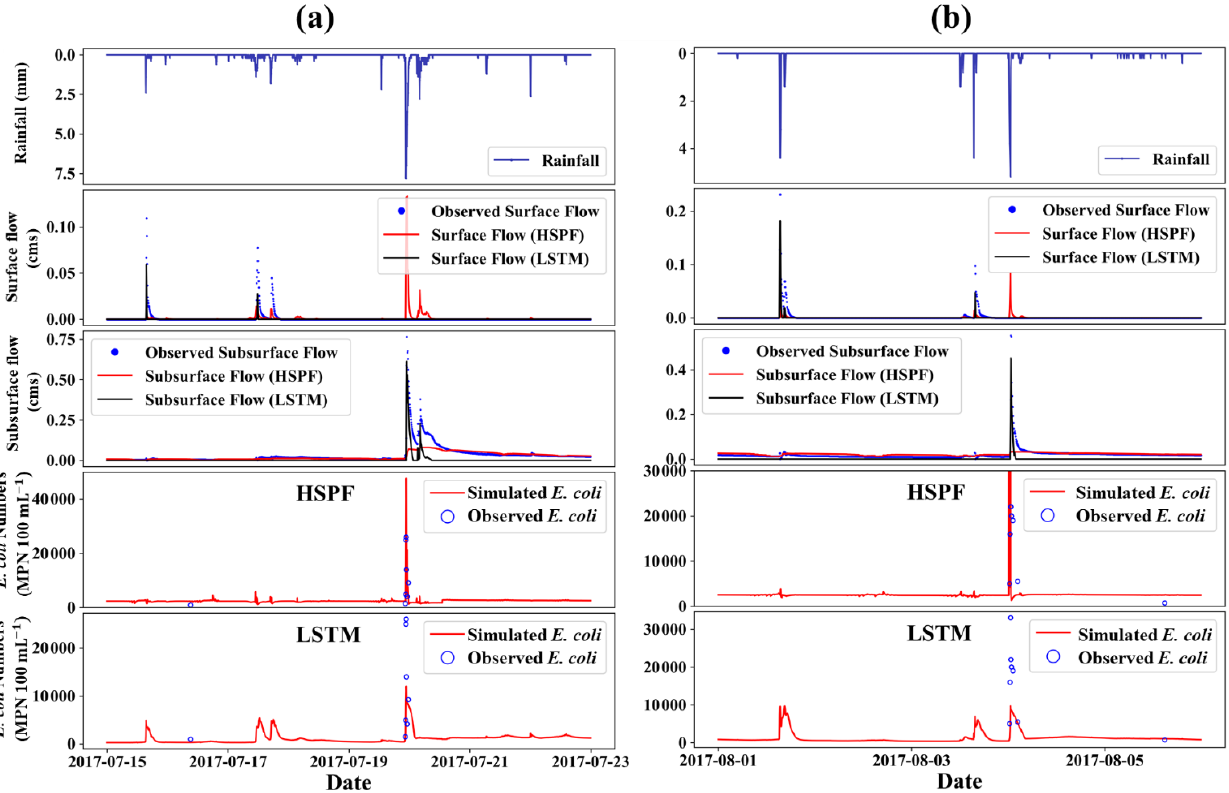
Figure 7. E. coli concentration simulated by HSPF and LSTM during 15–22 July (a) and 1–5 August 2017 (b) . Both storm events were affiliated in the validation period.